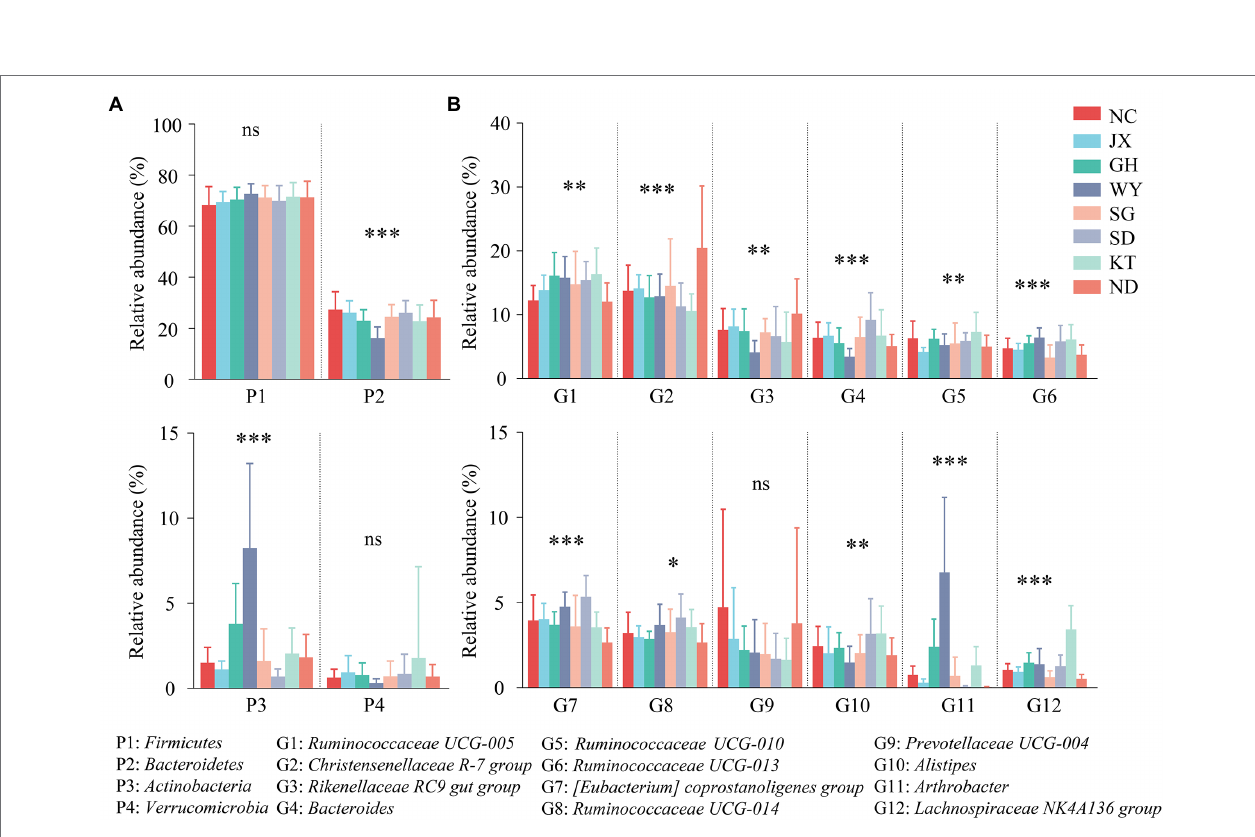
FIGURE 4 | PCoA analysis of gut microbiome in Przewalski’s gazelle based on Bray-Curtis distance matrices. *** p < 0.001.